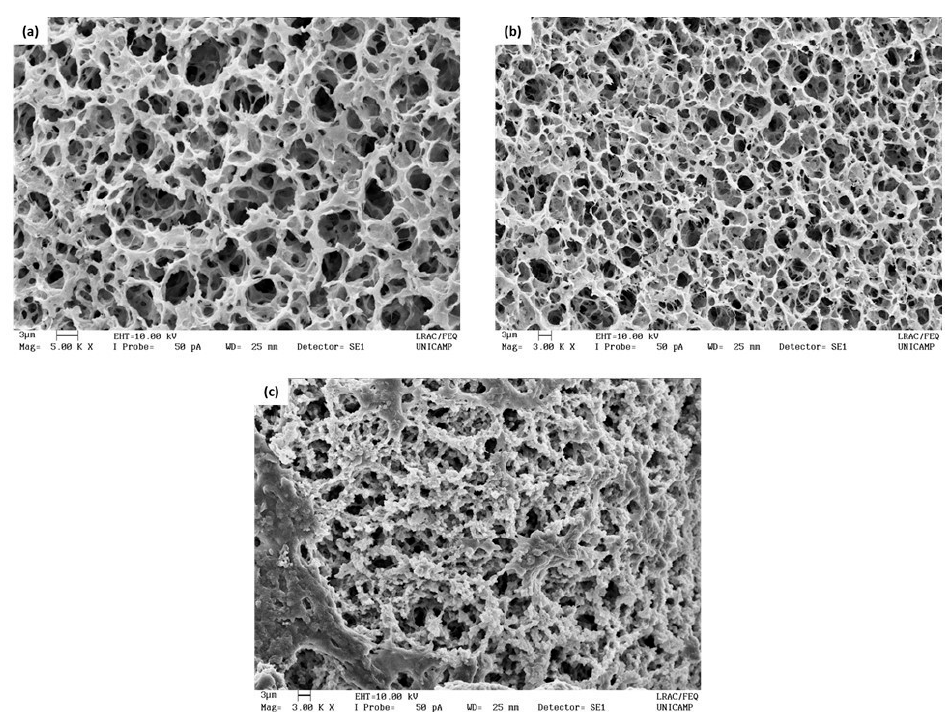
Figure 3. Scanning electron microscopy (SEM) images of hydrogels at 5000× magnification: ( a ) ET hydrogel, ( b ) BT/ET hydrogel, and ( c ) BT/PG hydrogel.